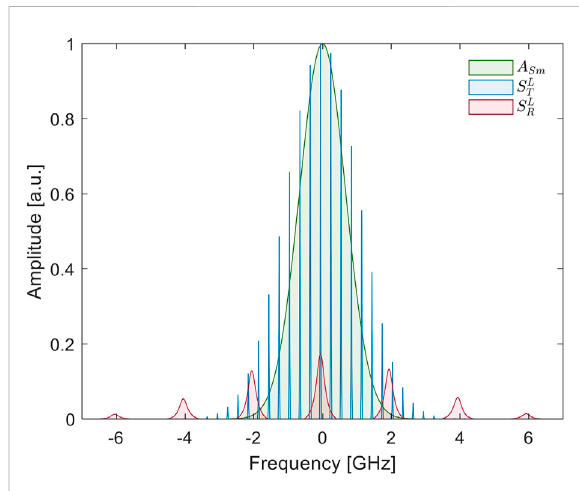
FIGURE 5 The different generated spectra for simulations, including the Sm Doppler broadened Gaussian and the Ti:Sa and Raman laser spectra, both presenting Lorentzian truncated